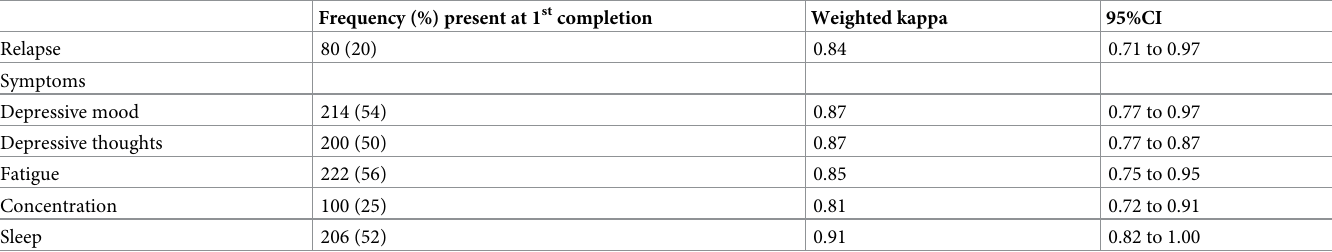
scores, the other two red lines (-3.9 and 3.4) are two standard deviations above and below the mean difference. Most of the observations lay within the two SD (with 4.7% (n = 19) out) and are randomly scattered over the lengths of the scale, which indicates no bias between 1 st and 2 nd completion of the rCIS-R, nor with increasing score. Table 2. Level of agreement for relapse in depression, individual symptoms, between 1 st and 2 nd completion of retrospective CIS-R. Frequency (%) present at 1 st